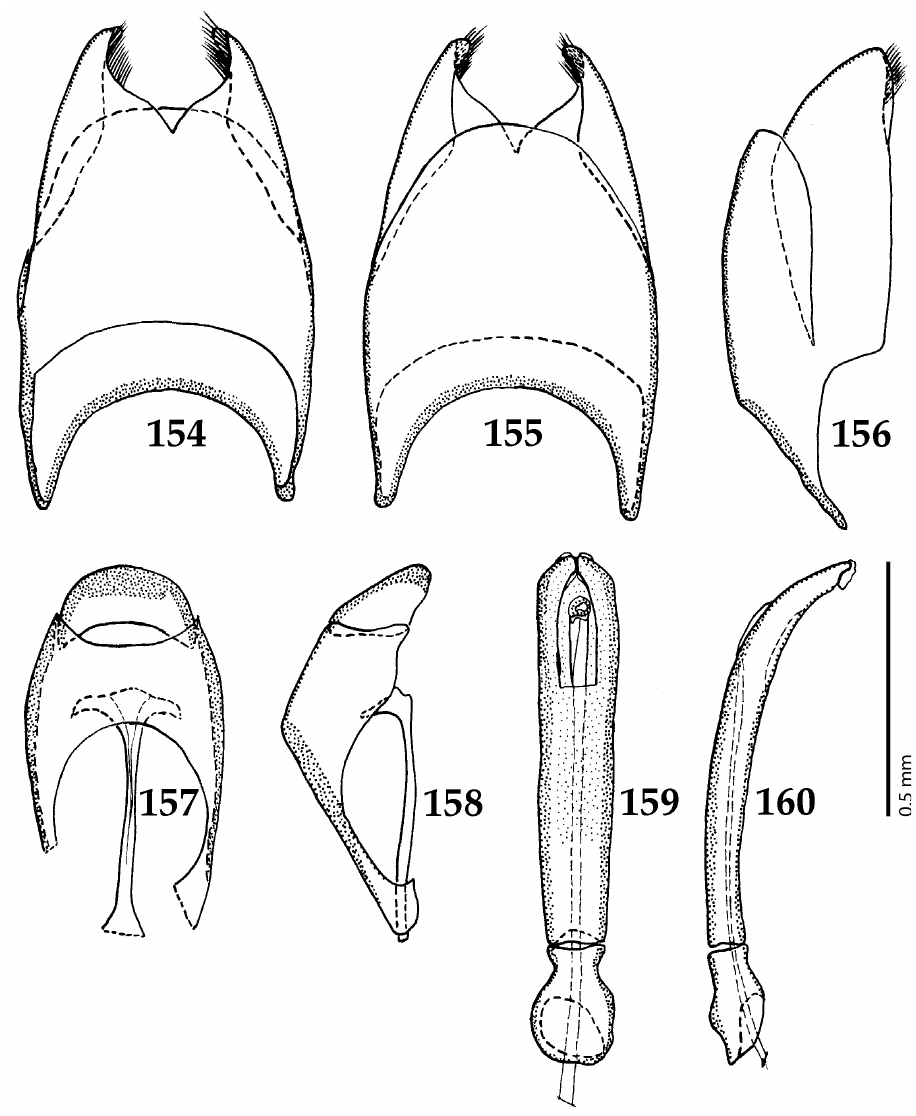
Figures 154–160. 154 Hypocaccus ( Hypocaccus ) brasiliensis (Paykull, 1811) male terminalia: 8 th sternite + 8 th tergite, ventral view 155 ditto, dorsal view 156 ditto, lateral view 157 male terminalia: 9 th + 10 th tergites, dorsal view; spiculum gastrale, ventral view 158 male terminalia: 9 th + 10 th tergites; spiculum gastrale, lateral view 159 male terminalia: aedeagus, dorsal view 160 ditto, lateral view. 108). Because of the ambiguous label data (see above) as well as no locality indication of the cotype we decided not to designate a lectotype of this